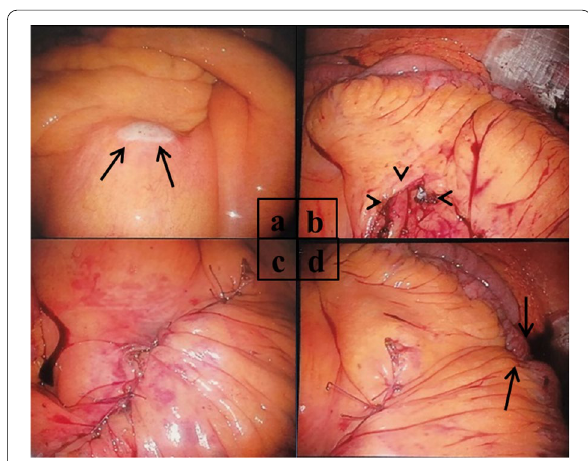
Fig. 8 a Intraoperative findings revealed that lymph node metastasis occurred in the mesentery of the ileum. The arrow shows the lymph node metastasis in the ileal mesentery. b–d Lymphadenectomy was performed, and the arrowhead shows the defect of ileal mesentery after lymphadenectomy. The arrow shows the anastomosis where the first operation of the partial resection of invaded ileum was done, and it was near the lymph node metastasis location